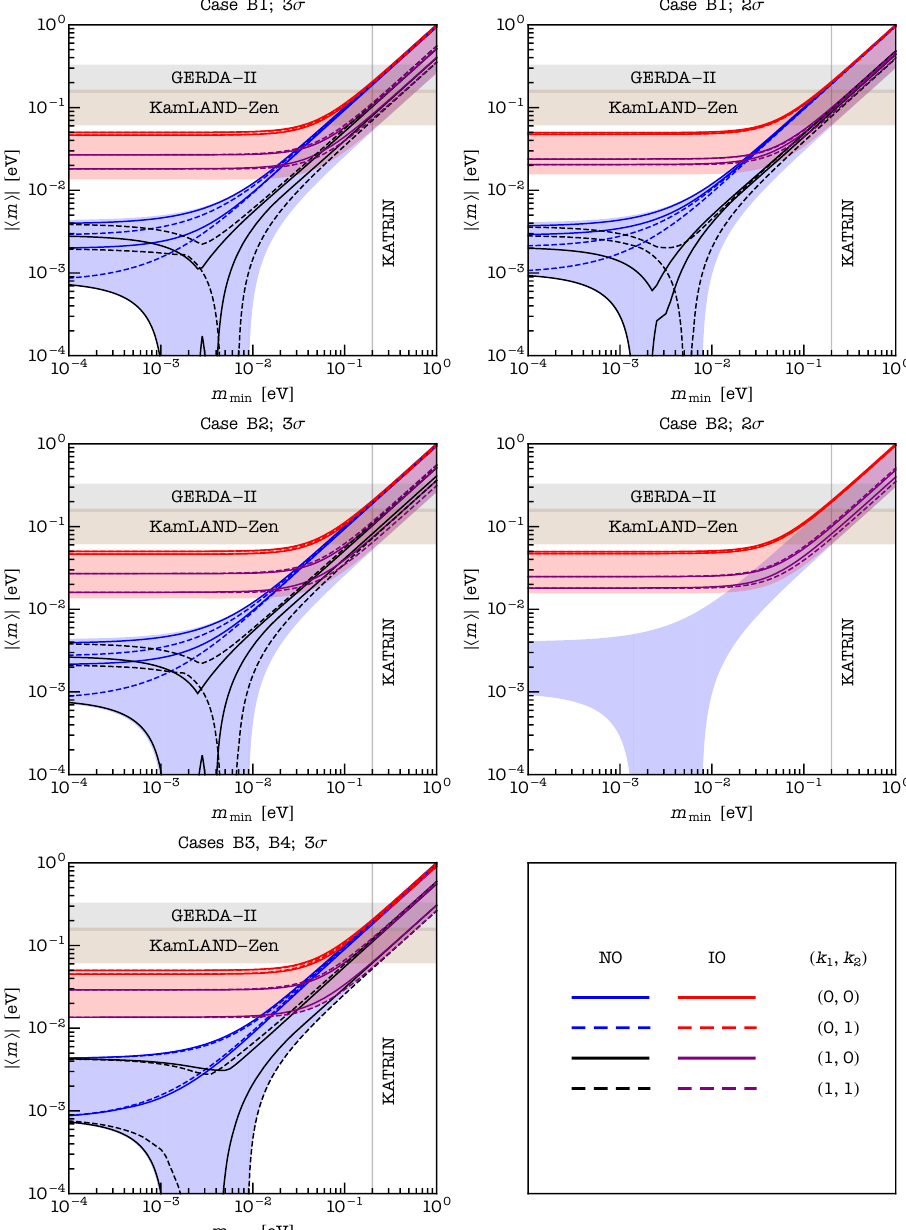
Figure 13 . The magnitude of the e(cid:11)ective Majorana mass jh m ij versus the lightest neutrino mass m min . The lines limit the allowed regions of jh m ij calculated using the predictions for the relevant mixing angles and the CPV phases obtained in cases B1{B4 and compatible with the 3 (cid:27) ( left panels ) and 2 (cid:27) ( right panels ) ranges of all the three mixing angles. The light-blue ( light-red ) areas are obtained varying the neutrino oscillation parameters (cid:18) 12 , (cid:18) 13 , (cid:1) m 2 in their allowed 3 (cid:27) and 2 (cid:27) ranges in the left and right panels, respectively, and the phases (cid:11) 21 and ( (cid:11) 31 (cid:0) 2 (cid:14) ) in the interval [0 ; 2 (cid:25) ). The horizontal brown and grey bands indicate the current upper bounds on jh m ij quoted in eq. (4.1) set by KamLAND-Zen [54] and GERDA Phase II [55], respectively. The vertical grey line represents the prospective upper limit on m min (cid:24) < 0 : 2 eV from KATRIN [61]. Cases B3 and B4 are compatible with the 3 (cid:27) ranges of the mixing angles, but not with their 2 (cid:27) ranges.